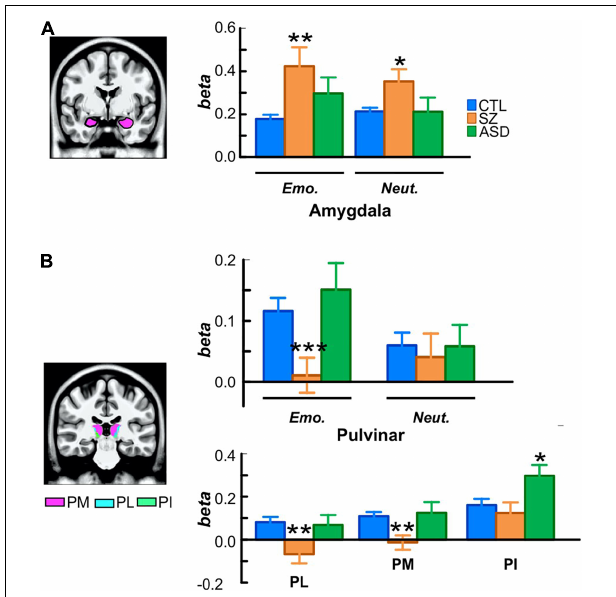
FIGURE 4 | (A) Localization and activation of the amygdala in each participant group, superimposed on an MNI template volume. (B) Localization of the medial (pink; PM), lateral (cyan; PL), and inferior (green, PI) subdivisions of pulvinar. For each group, bar plots (top) are of beta values for emotional and neutral faces extracted from the whole pulvinar and (bottom) of mean betas from each subdivision. * p < 0.05; ** p < 0.01; *** p < 0.001.